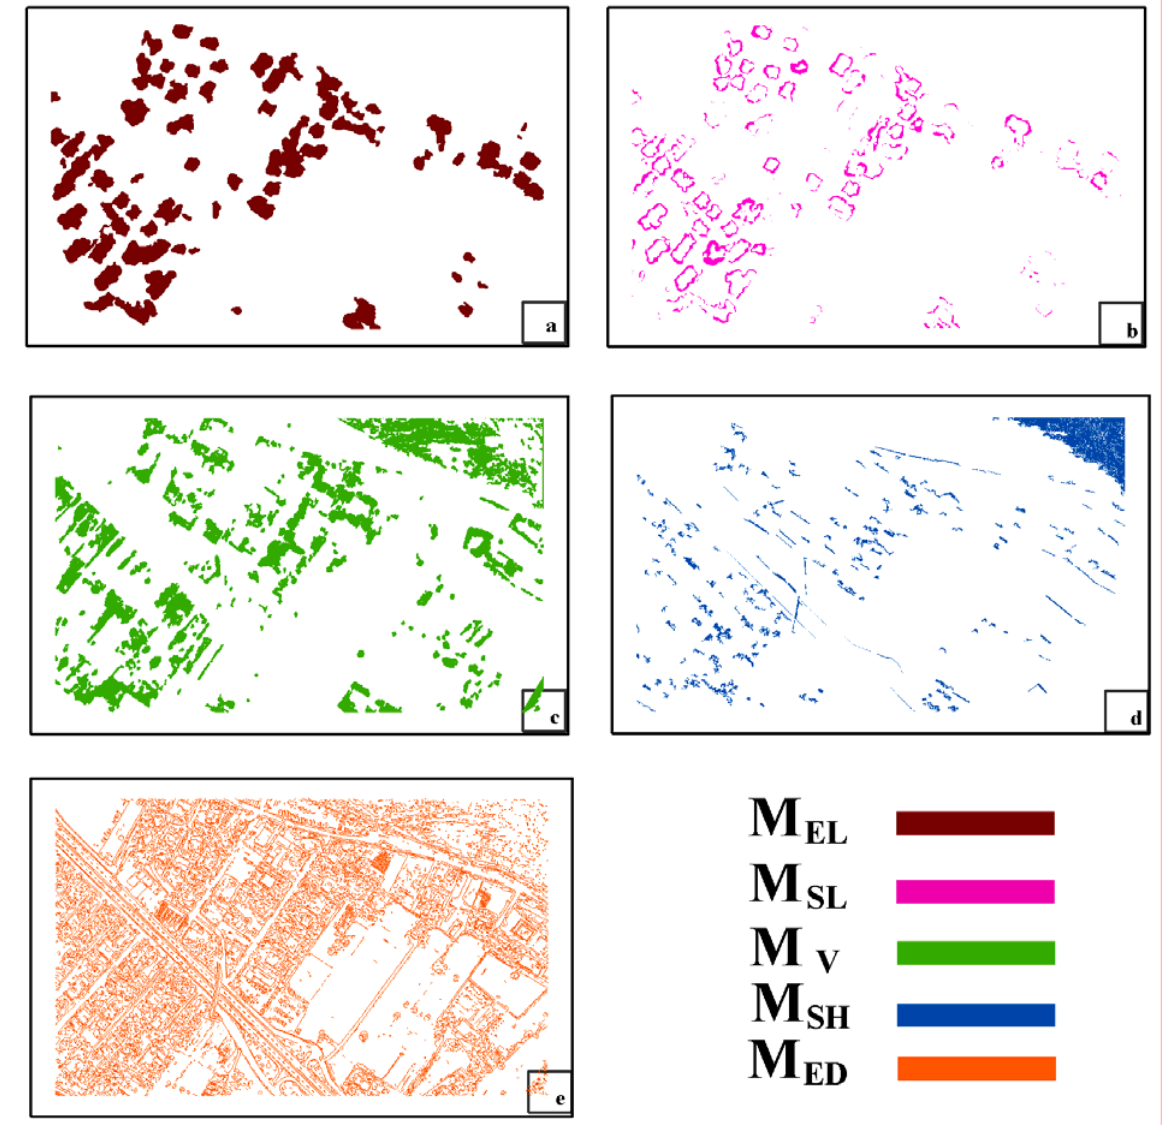
Figure 3. Intermediate raster data: (a) Elevation mask-layer M , (c) Vegetation mask-layer M M SL M ED